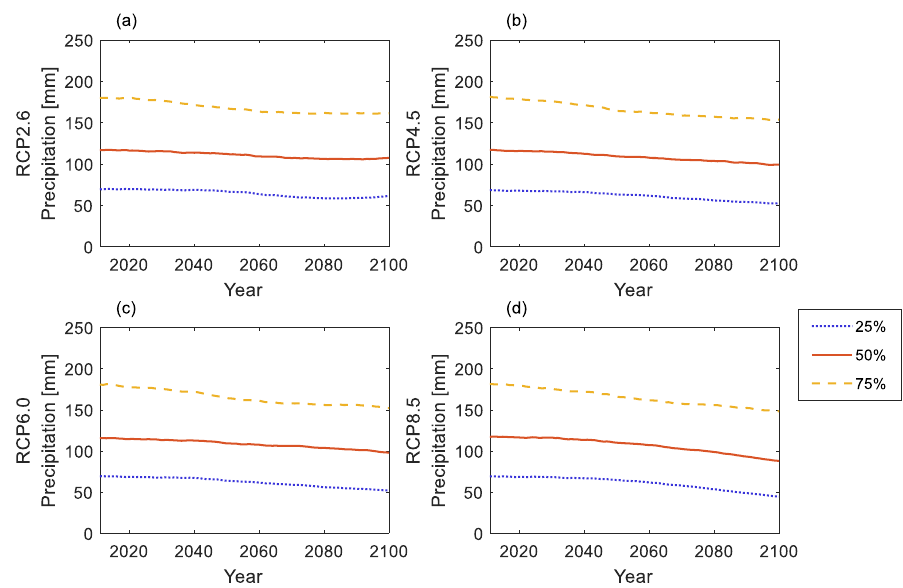
Figure 4. Projected precipitation for the Paloma Embalse station gauge (320 m a.s.l., 30 ◦ 41 (cid:48) 48 (cid:48)(cid:48) S, 71 ◦ 02 (cid:48) 18 (cid:48)(cid:48) W) under RCP 2.6 ( a ), 4.5 ( b ), 6.0 ( c ) and 8.5 ( d ). The 25th (dotted line), 50th (solid line), 75th (dashed line) of annual percentiles is averaged over a 40-year moving window, with the horizontal axis being the last year of the